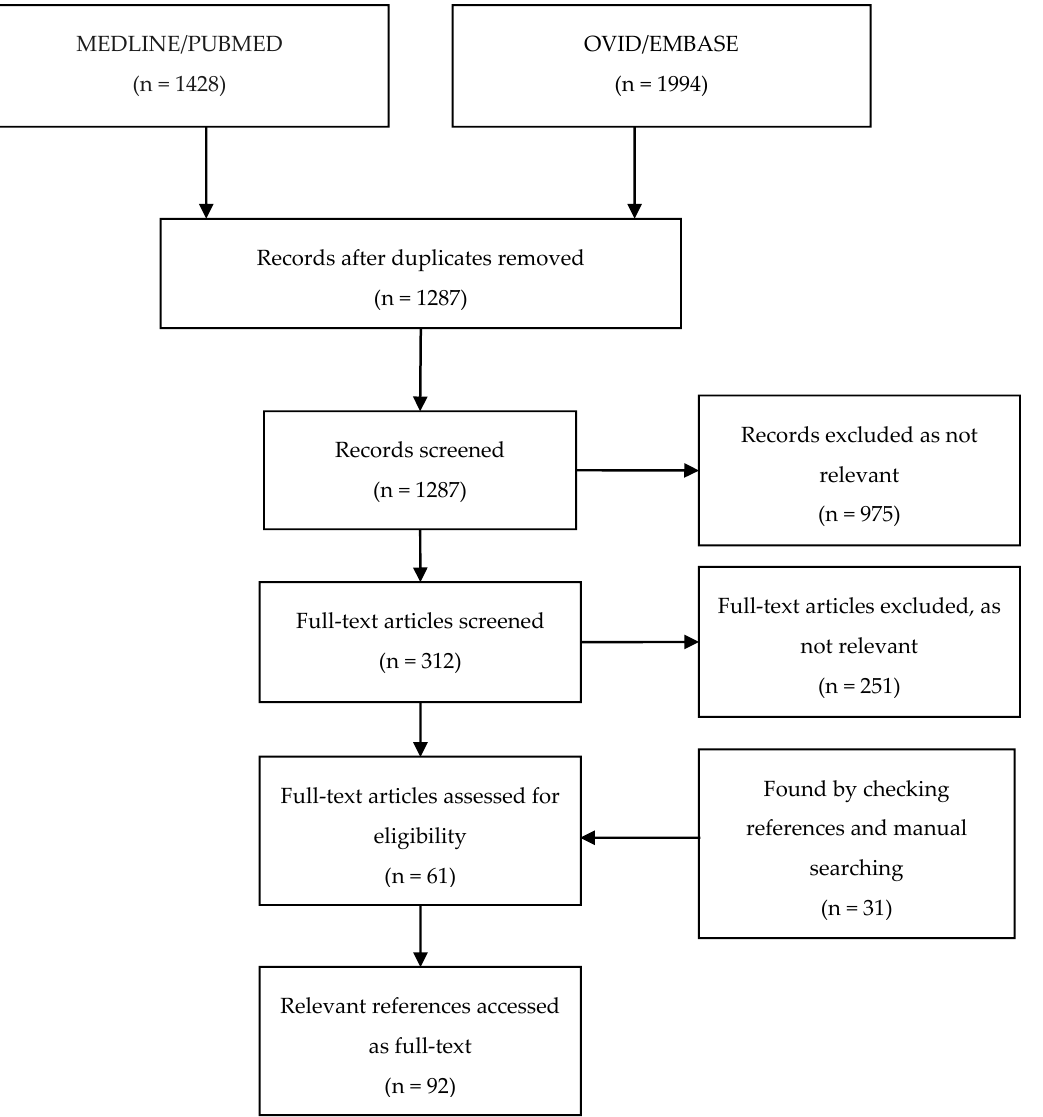
Figure 1. Flow-chart depicting the systematic search process and articles included.